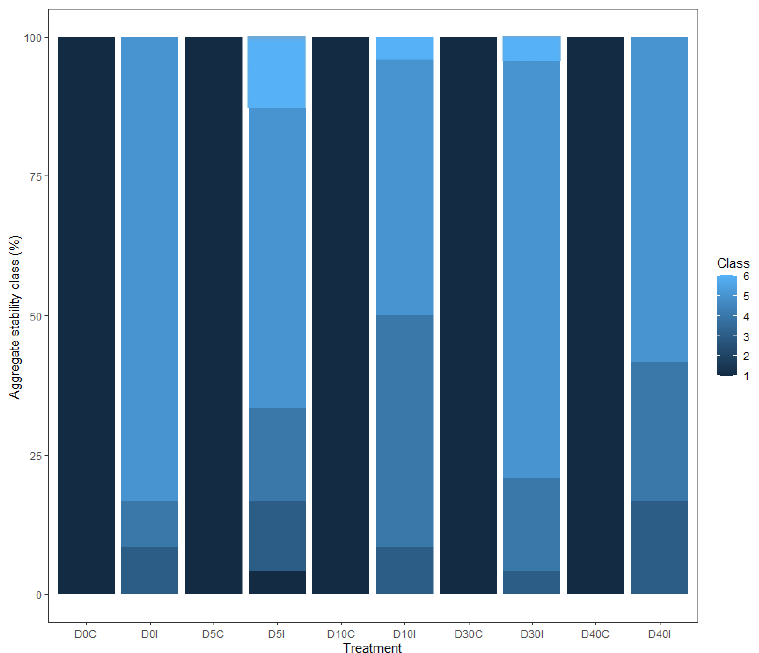
Figure 3. Percentage of each aggregate stability class in the samples of all doses of sewage sludge (t ha − 1 ) tested for both control (C) and inoculated (I) samples 4 months after cyanobacteria inoculation. Agriculture 2022 , 12 , x FOR PEER REVIEW Regarding wind erodibility, the amount of sediment displaced by the wind force ap ‐ plied increased with SS dose because of the higher coarse particle content in the amended samples (Figure 4). Cyanobacteria inoculation strongly decreased particle displacement, and significant differences were found between inoculated and control soils for almost all the SS concentrations tested (Figure 4).